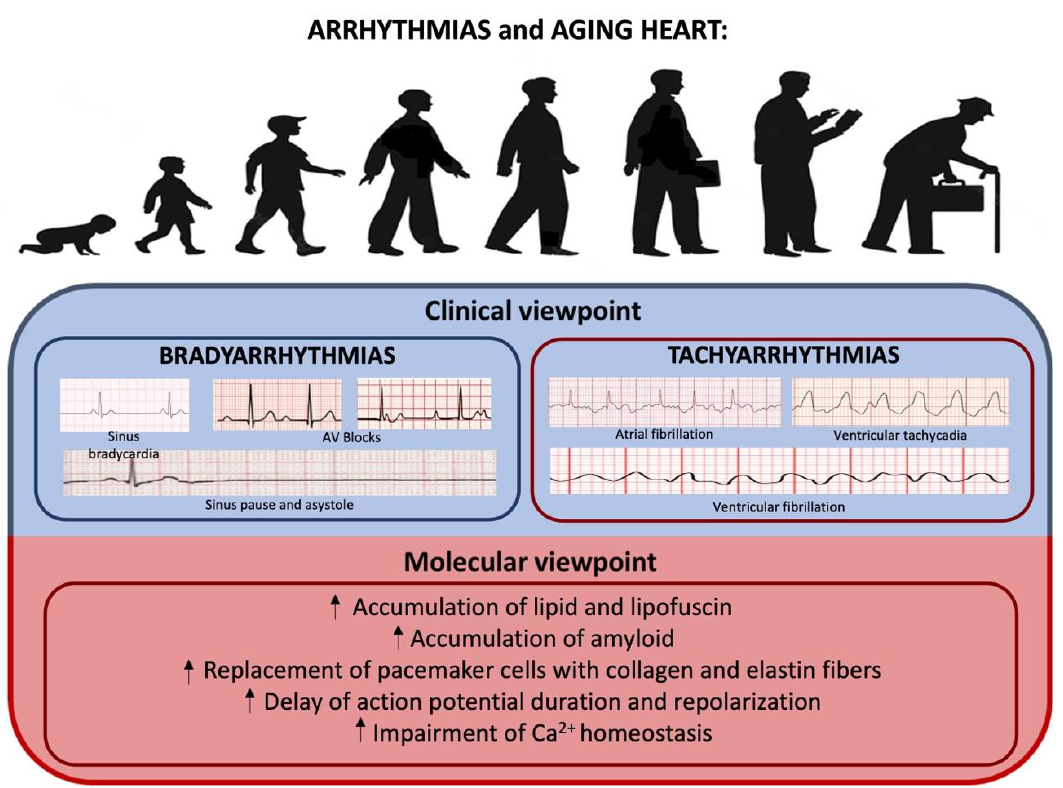
Figure 5. Aging heart and arrhythmias: from clinical to molecular viewpoint. The aging process may be one of the main promoting factors for bradyarrhythmias and tachyarrhythmias. Table 3. Molecular mechanisms and intracellular modifications underlying